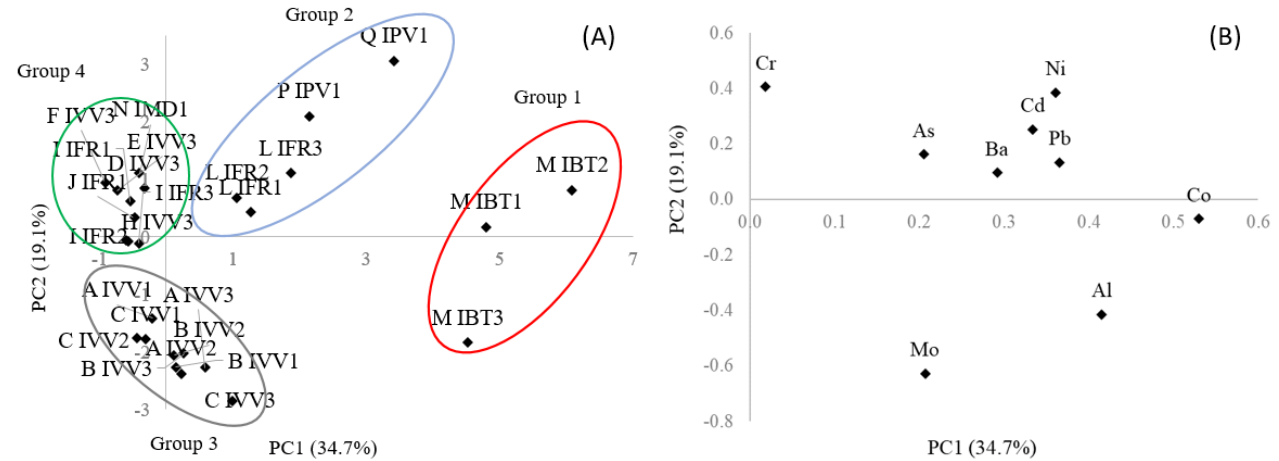
Figure 1. Principal Component Analysis of toxic inorganic elements in plant-based yogurts. Graphs of scores ( A ) and loadings ( B ). Group 1 (red circle): sample of brand M; Group 2 (blue circle): samples of brands L, P and Q; Group 3 (gray circle): samples of brands A, B and C; Group 4 (green circle): samples of brands D, E, F, G, H, I, J, K, N, O and R.